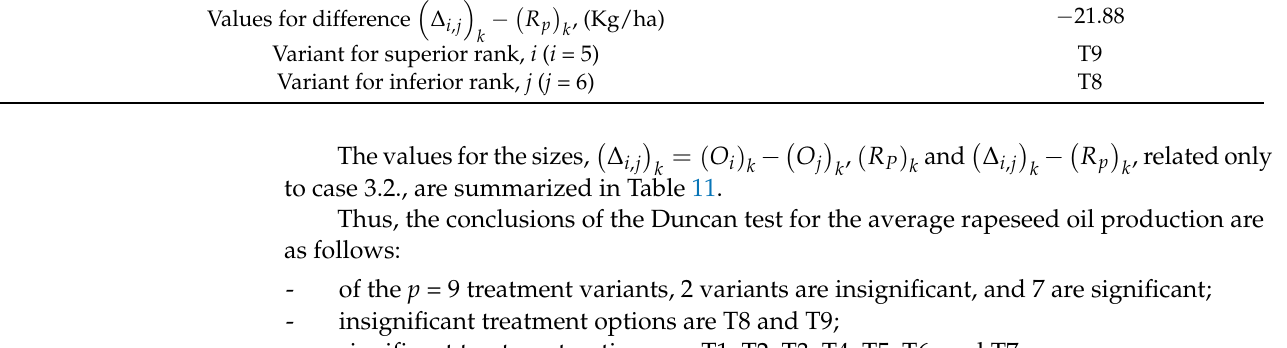
(cid:17) (cid:16) (cid:16) (cid:17) ∆ ∆ − (cid:0) R p (cid:1) , ( R P ) and related to case 3.2. i , j i , j k k k k (cid:16) (cid:17) ∆ ,(Kg/ha) 41.30 i , j k , (Kg/ha) 63.18 k (cid:17) (cid:16) ∆ − (cid:0) R p (cid:1) , (Kg/ha) − 21.88 i , j k k